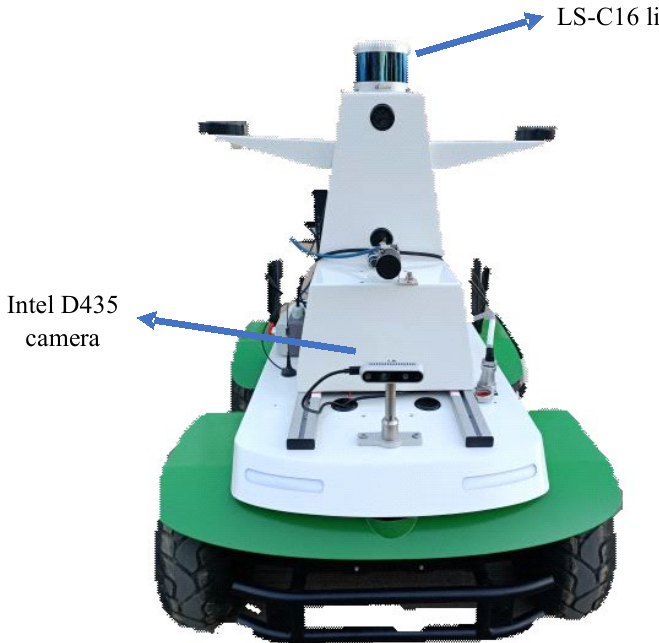
Figure 6. Experimental platform.